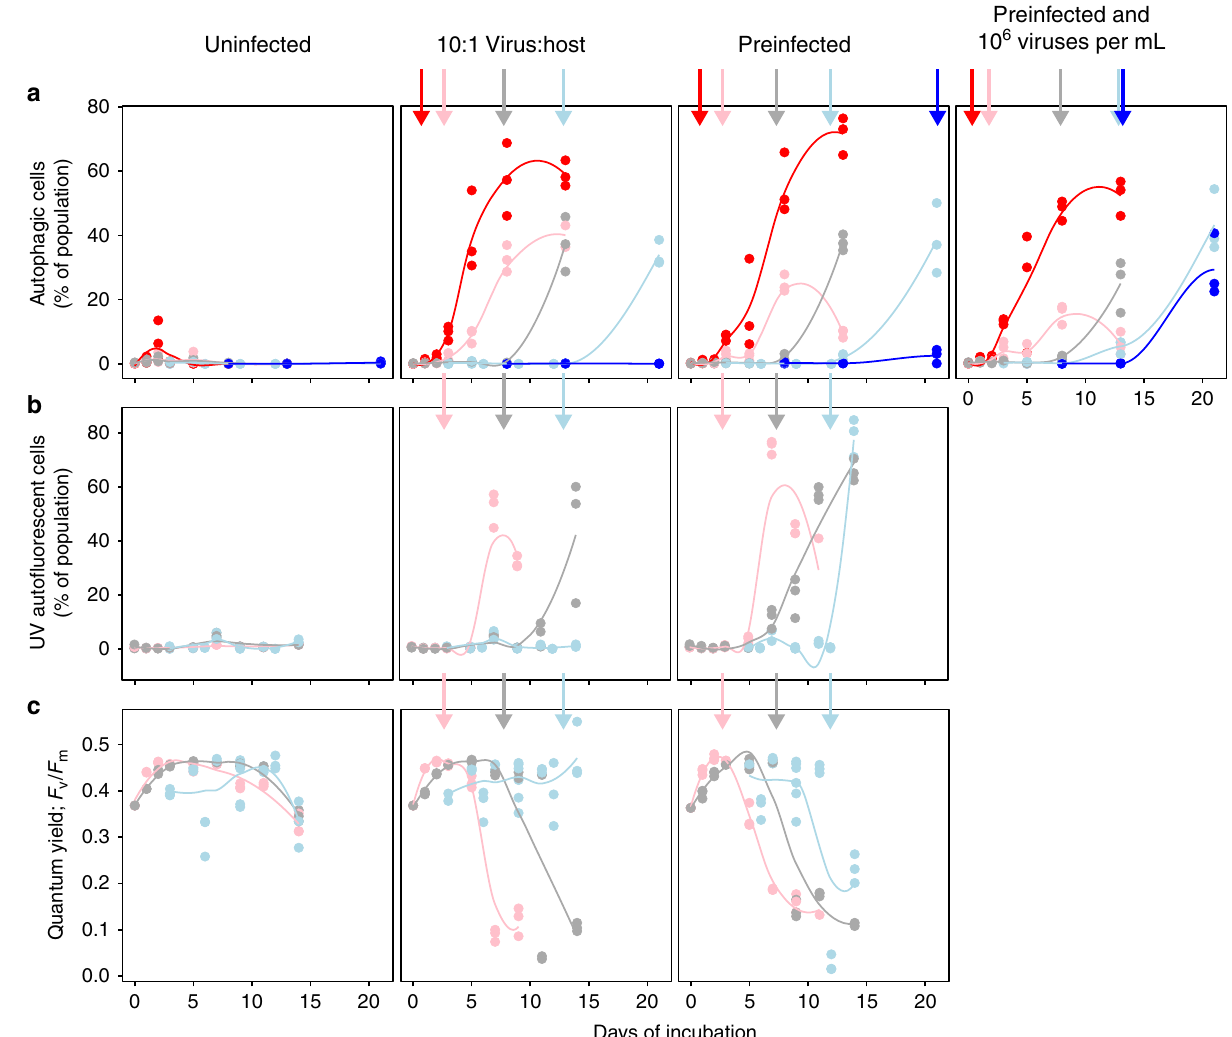
Fig. 2 Infection remains dormant until the onset of host physiological stress. Host physiological stress as the percent of cells a undergoing autophagy (Lysotracker stain positive; n = 534 counts across two independent experiments), b exhibiting elevated ultra-violet auto fl uorescence from metabolic dysfunction ( n = 295 counts across two independent experiments), or c showing declining population photochemical quantum yield of PSII ( F v / F m ; n = 284 counts across two independent experiments) across uninfected, infected 10:1 virus:host multiplicity of infection (MOI) co-incubations, and pre-infected hosts without or with extracellular viruses added treatments. All analyses had a 10 3 cells per milliliter detection threshold (see Supplementary Fig. 13b, c). lines of best fi t, respectively. Vertical arrows show average onset of host lysis in each density treatment. Independent experiments are summarized in Supplementary Table 1. Source data are provided as a Source Data fi